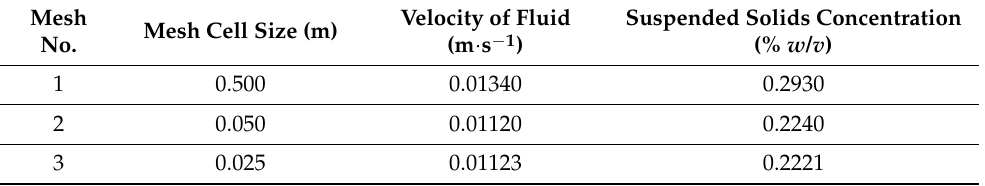
Table 2. Predicted effluent suspended solids concentration and velocity from each mesh evaluated in CFD